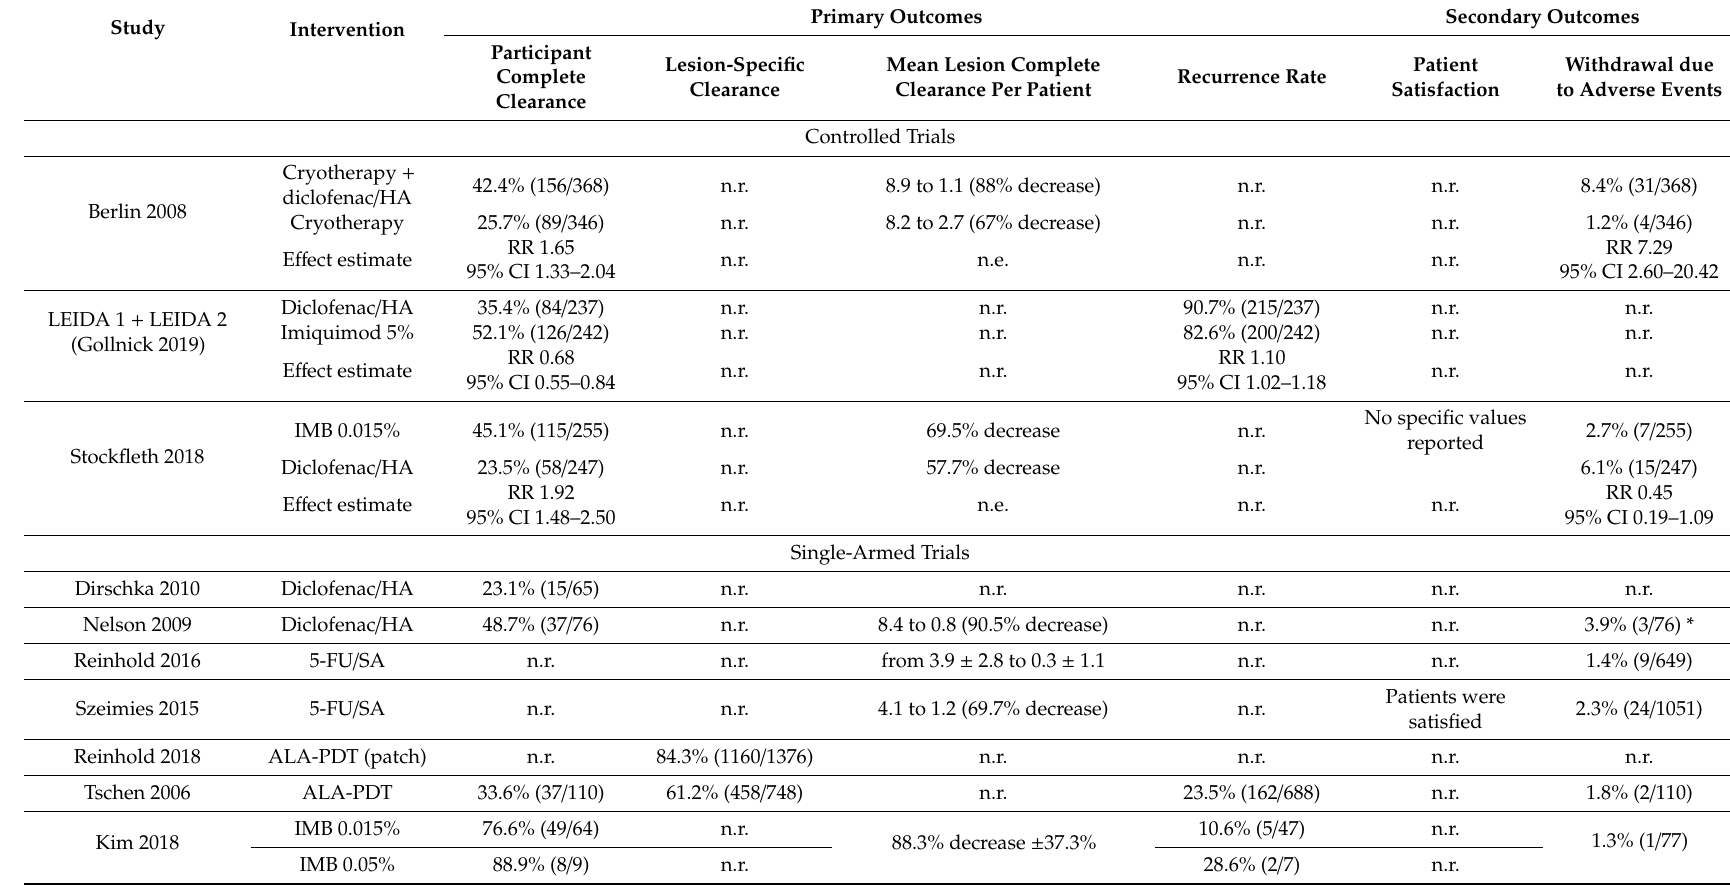
Table 2. Summary of the primary and secondary